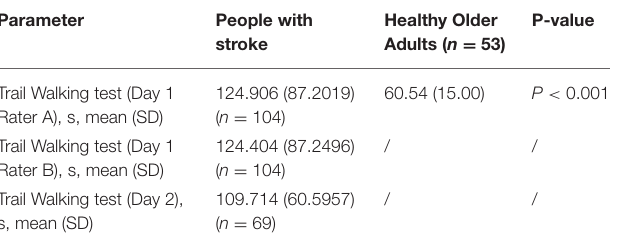
TABLE 2 | Mean trail walking test (TWT) completion times for people with stroke and healthy older adults.